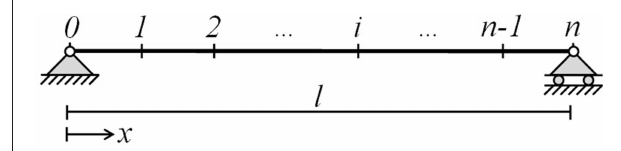
FIGURE 1 | Beam, with length l, equipped with sensors at n+1 locations (cross-sections) providing known curvature values at each